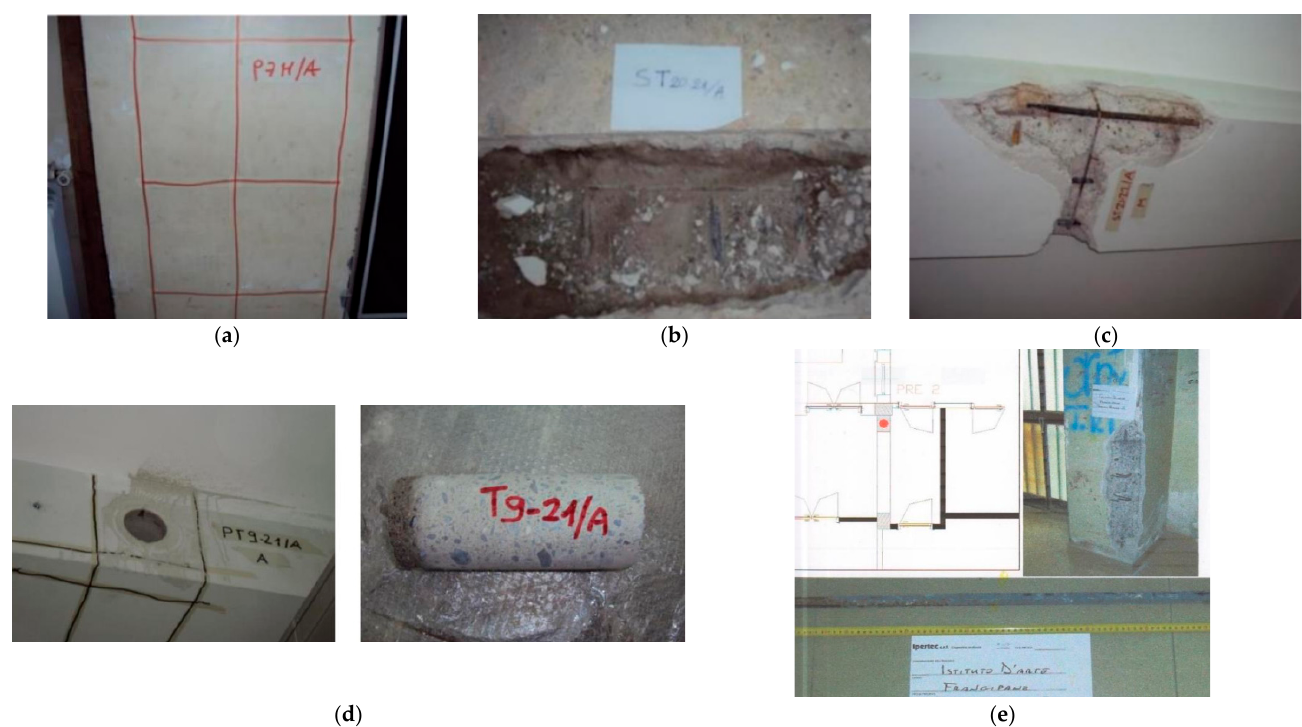
Figure 7. In-field experimental investigation (selected examples): ( a ) magnetometric inspection for a pillar; ( b ) foundation system; ( c ) rebars and stirrups of RC members; ( d , e ) concrete and steel rebar samples for mechanical characterization of materials.